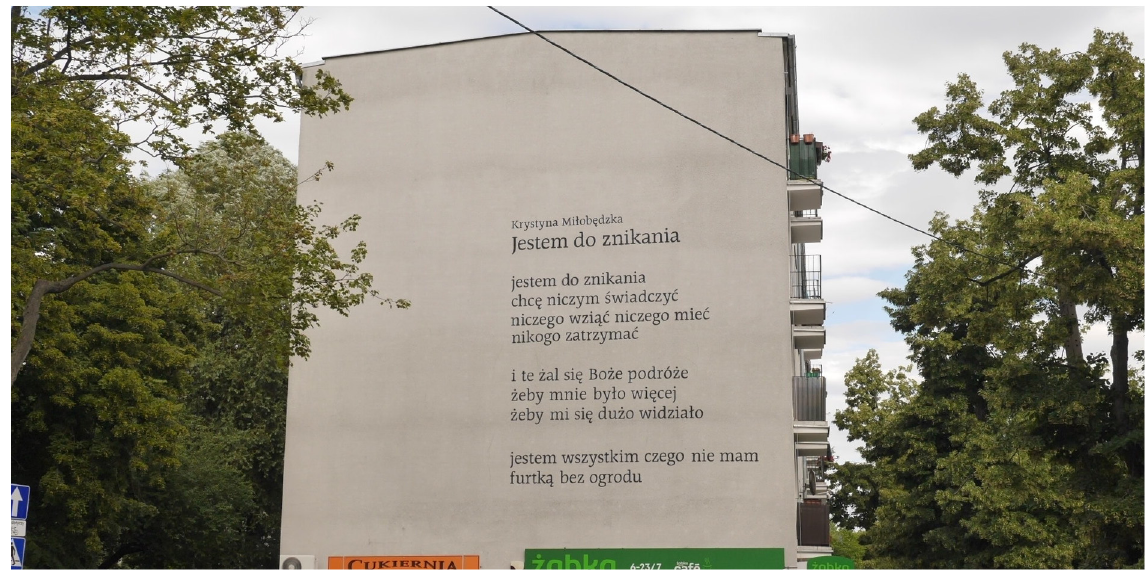
Figure 10. © photography by Pawe ł J ę drzejczak. Mural of a poem by Krystyna Mi ł ob ę dzka, jestem do znikania (I am to disappear) in Lodowa street in Pozna ń , made in a frame of project by Joanna Pa ń czak and Tomasza Genowa.